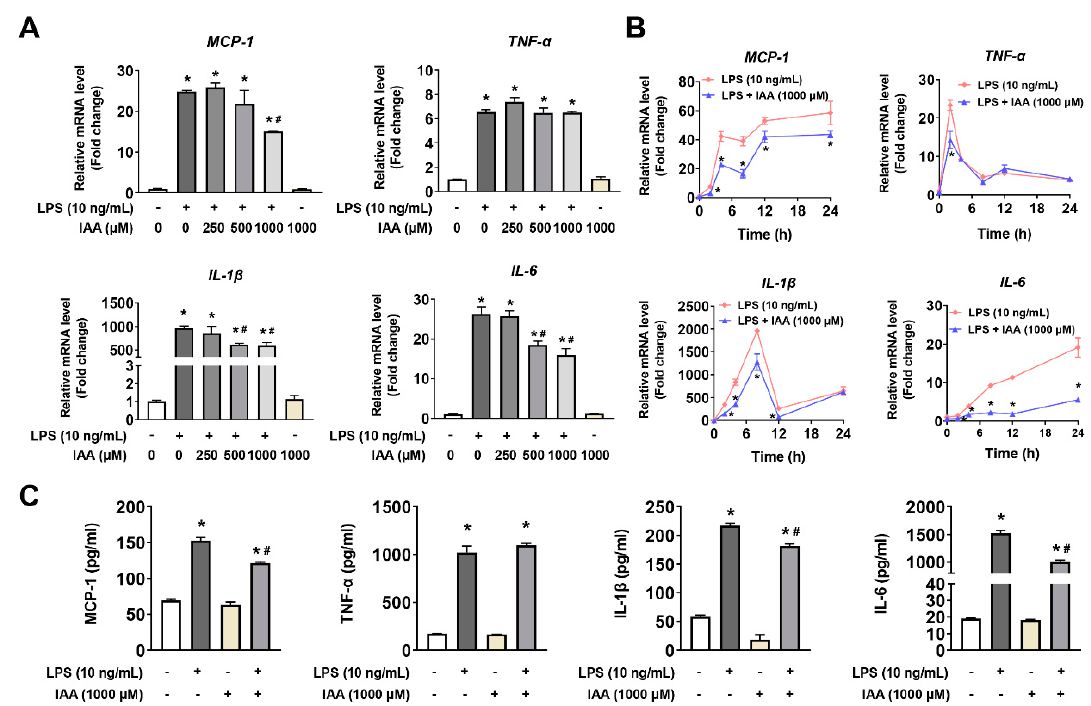
Figure 2. E ff ects of IAA on LPS-induced mRNA expression and secretion of proinflammatory cytokines in RAW 264.7 cells. ( A ) mRNA levels relative to β -actin in cells exposed to LPS following treatment with IAA. Cells were treated with various concentrations (0, 250, 500, 1000 µ M) of IAA for 12 h, and then incubated with LPS (10 ng / mL) in the presence or absence of IAA for 8 h. β -actin was considered as house-keeping gene. Results are mean ± SEM. n = 3. * p < 0.05 versus control group; # p < 0.05 versus LPS group. ( B ) Time-course results of relative mRNA levels of proinflammatory cytokines. Cells were pretreated with or without IAA for 12 h, followed by LPS stimulation in the present or absence of IAA for 0, 2, 4, 8, 12, and 24 h. β -actin was regarded as reference gene. Results are shown as mean ± SEM. n = 3. * p < 0.05 versus LPS group. ( C ) Secretion of proinflammatory cytokines were detected by ELISA at 16 h following LPS stimulation in the presence or absence of IAA after a 12 h treatment with IAA. Results shown are mean ± SEM. n = 3. * p < 0.05 versus control; # p < 0.05 versus LPS group. IAA, indole-3-acetic acid; LPS, lipopolysaccharide.